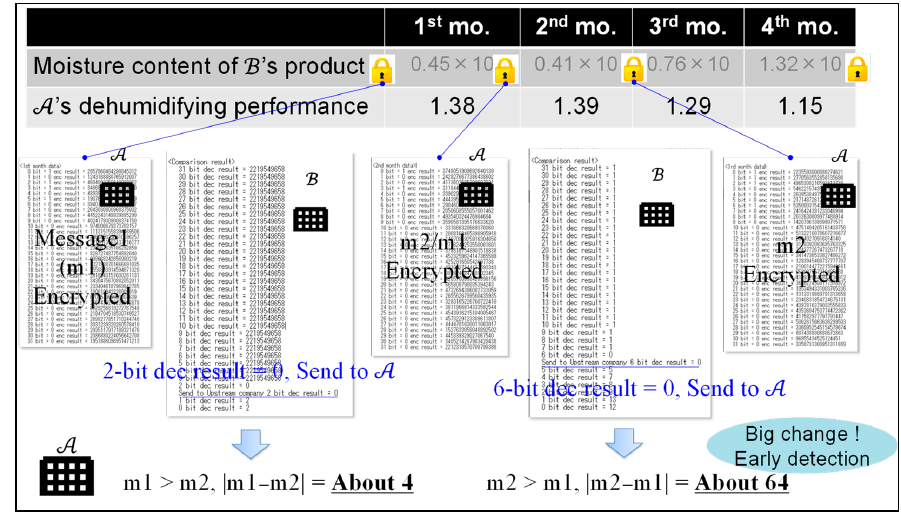
Figure 6. Evaluating the result of the concrete data collaboration.